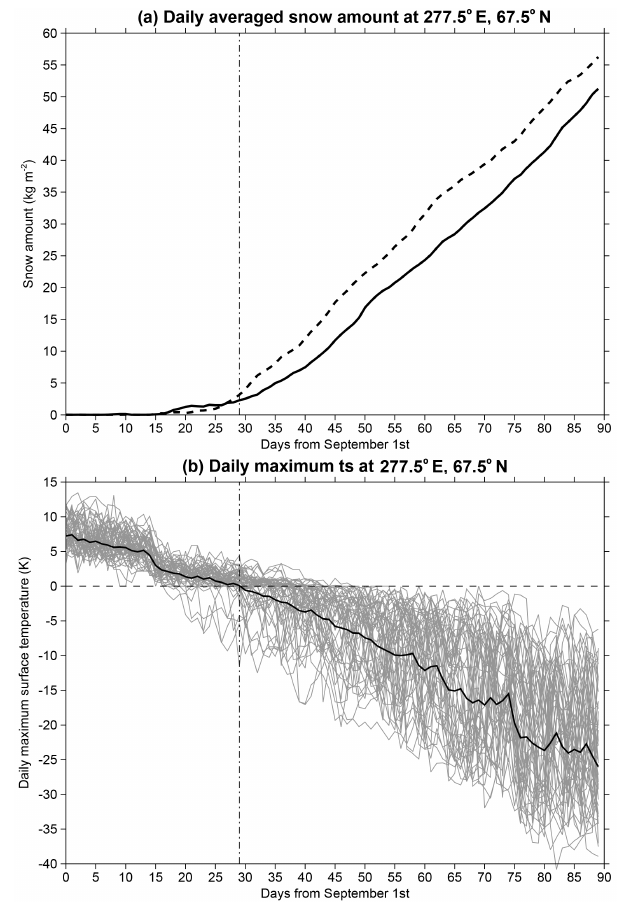
Figure 7. Time series of (a) mean daily snow amounts in SON av- eraged over 50 years of simulation in FREE (solid line) and CON1 (dashed line). (b) Time series of maximum daily surface tempera- tures during SON from all years in FREE (grey lines) and CON1 (solid black